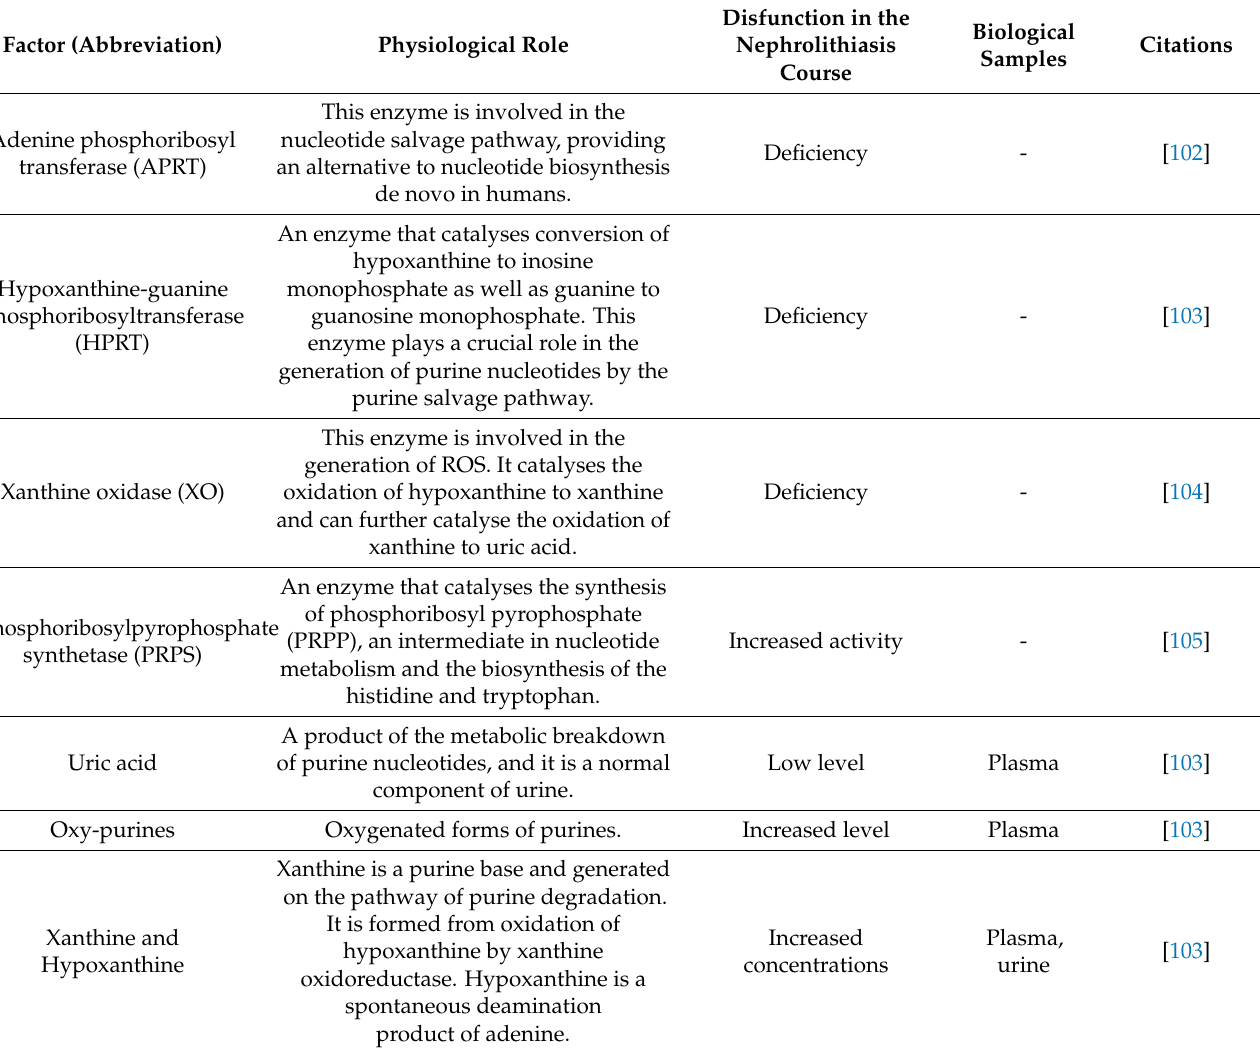
Table 3. Potential biomarkers associated with purine metabolism pathway in kidney stone diagnostics.